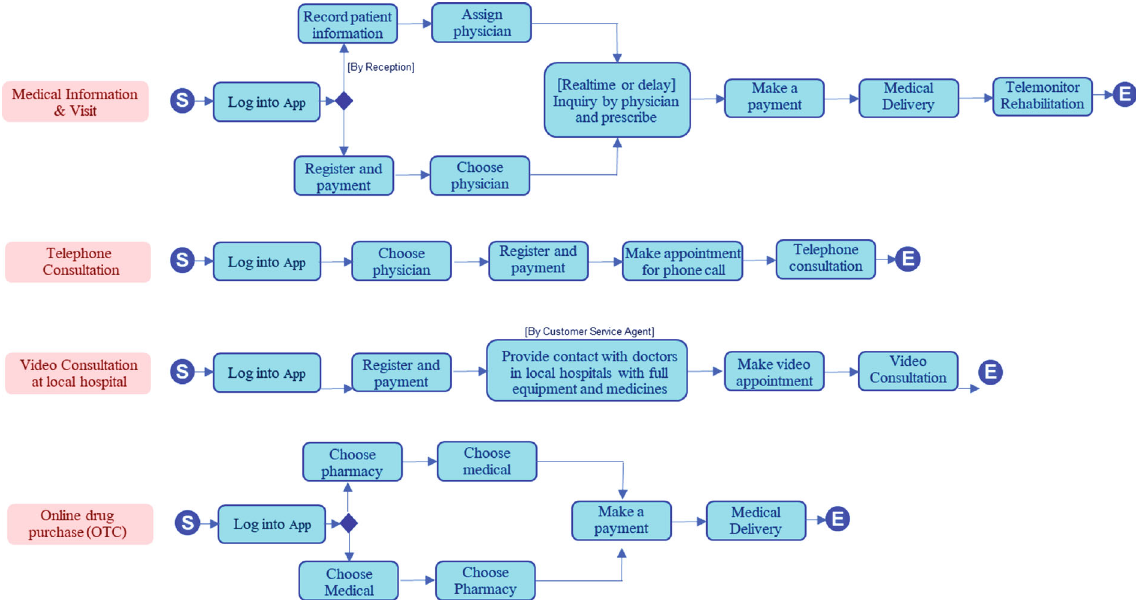
Figure 2: Existing telehealth patient journey